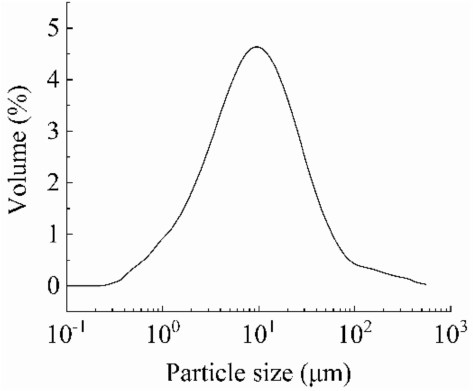
Figure 1. Size distribution of experimental biomass